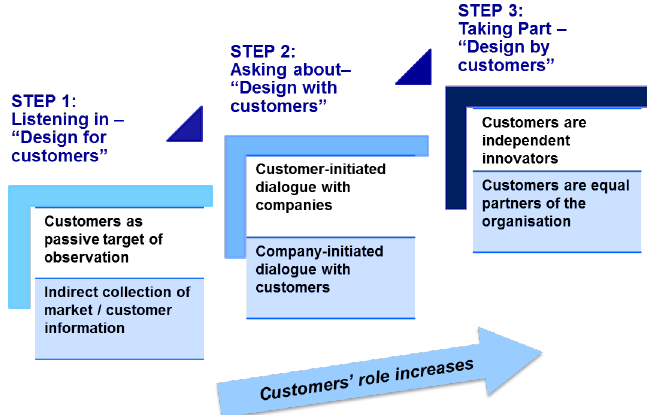
Fig. 1. Different levels of customer involvement in NPD process (modified from Reichwald and Piller,